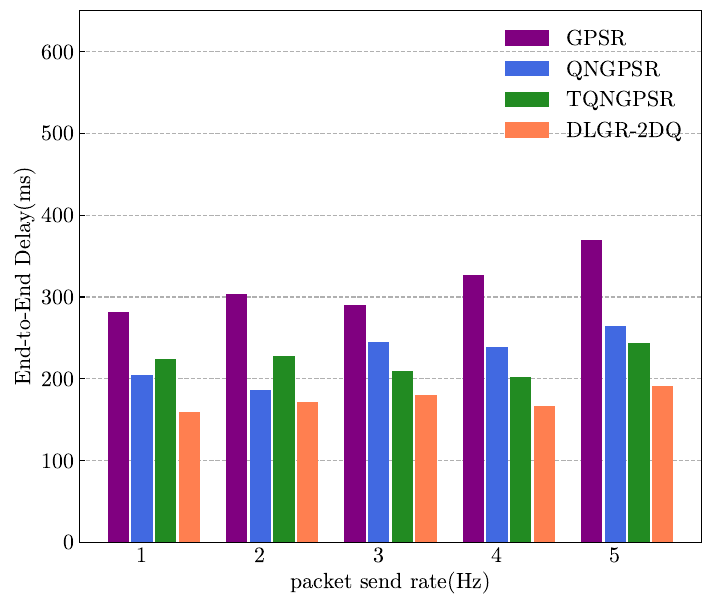
Figure 11. The effects of packet-sending rates on E2E delays. Figure 12 illustrates the results of the PDR versus different packet-sending rates. The PDR of DLGR-2DQ was the largest, due to the total waiting time of packets in a candidate forwarding node being considered in our proposed routing protocol. DLGR-2DQ avoided forwarding packets to congested nodes and considered the link quality, so the packet loss was the smallest, compared to that of the other three routing protocols. It was clear that with the increase in the packet-sending rate, the PDR of DLGR-2DQ